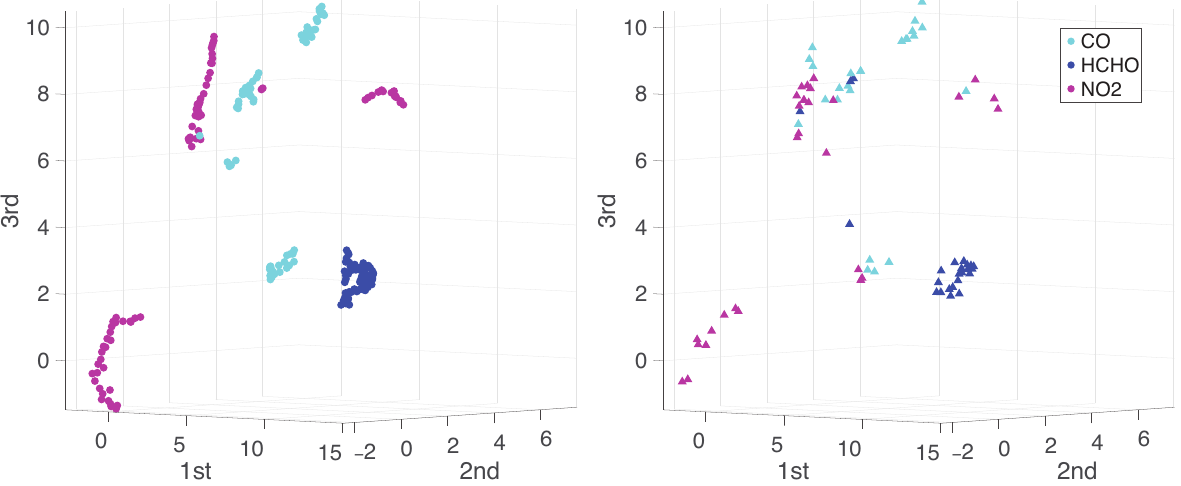
Figure 16. Scatter plot of the first three UMAP features of the data in dataset #3 (training set on the left and test set on the right ). The three different classes are shown in different colors.